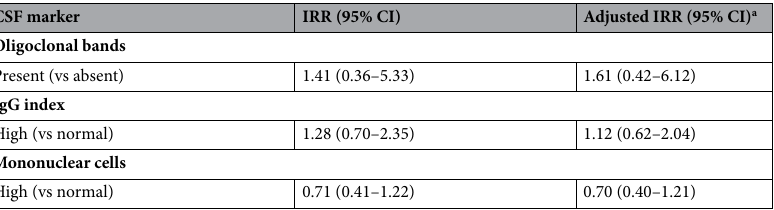
Table 4. Relationship between CSF values and relapse rate among pediatric-onset patients in the 5 years following baseline, using negative binomial regression. IRR incident rate ratio. a Adjusted for age at sampling, sex, region of Sweden, and time on first- and second-line DMTs.